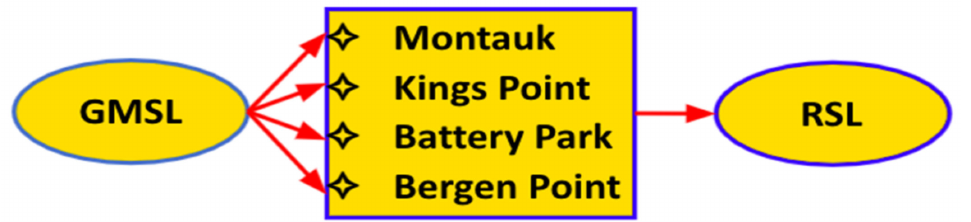
Figure 9. Pathway diagram of the Generalized Additive Model (GAM) to model the relationship between GMSL to RSL (Regional Sea Level) via four regional tidal gauge stations in the New York City and Long Island